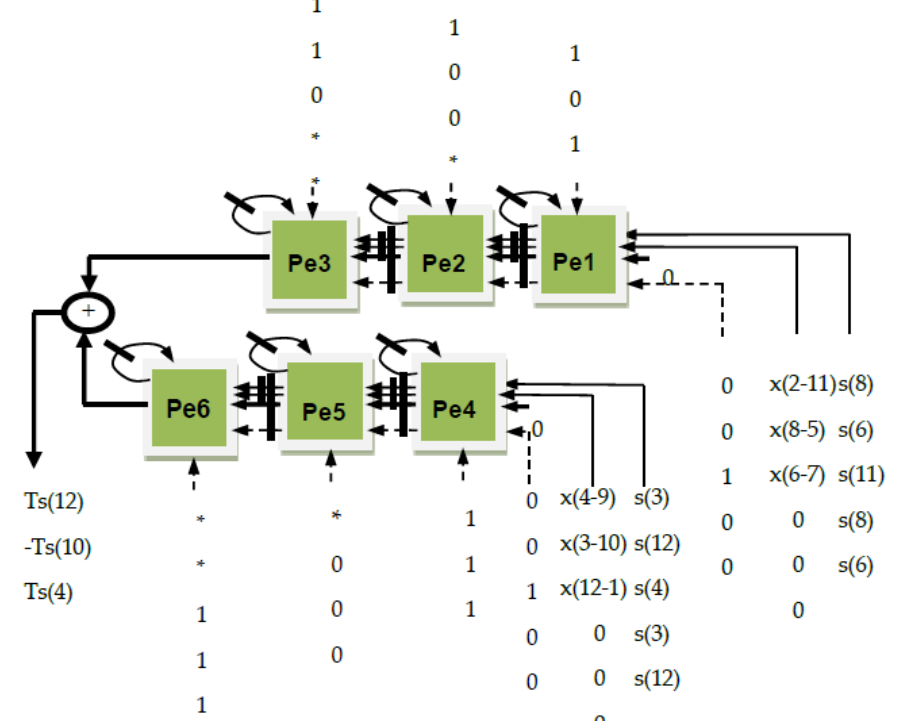
Figure 8. The VLSI architecture of the hardware core that implements Equation (31), where * marks a delay of one clock cycle. In Figure 9 we have mapped the data flow graph for Equation (32) and we have ob- tained another systolic array. We can see that the architecture presented is computing the auxiliary output sequences Ts(11), Ts(5) and Ts(7), using the auxiliary input sequences x(4 + 9), x(3 + 10), x(12 + 1), x(2 + 11), x(8 + 5) and x(6 + 7) of the DST-IV transform.